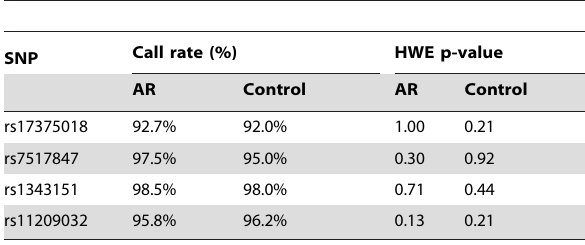
Table 2. The 4 SNP call rates in patients and control individuals and HWE p-values.